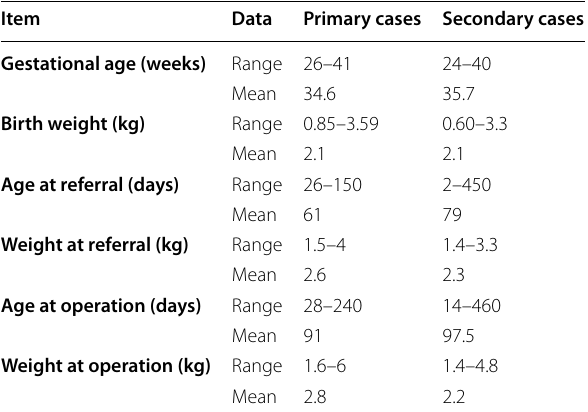
Table 2 Patients’ weight and age at time of referral and time of